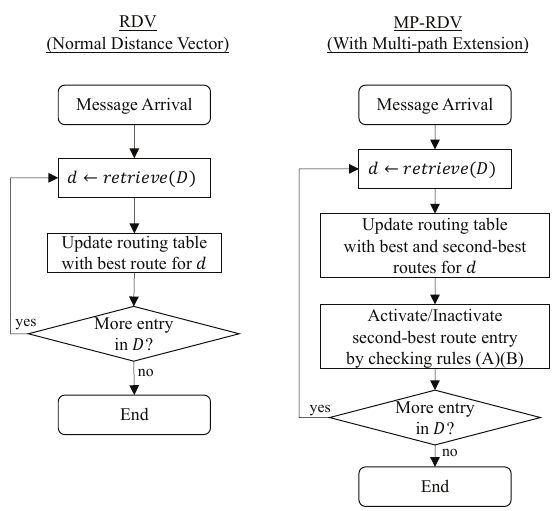
Figure 6. The flowcharts of routing-table updates in RDV and MP-RDV (Multi-Path RDV): MP-RDV maintains both the primary and secondary relays in the routing tables, and makes decisions on activating the secondary